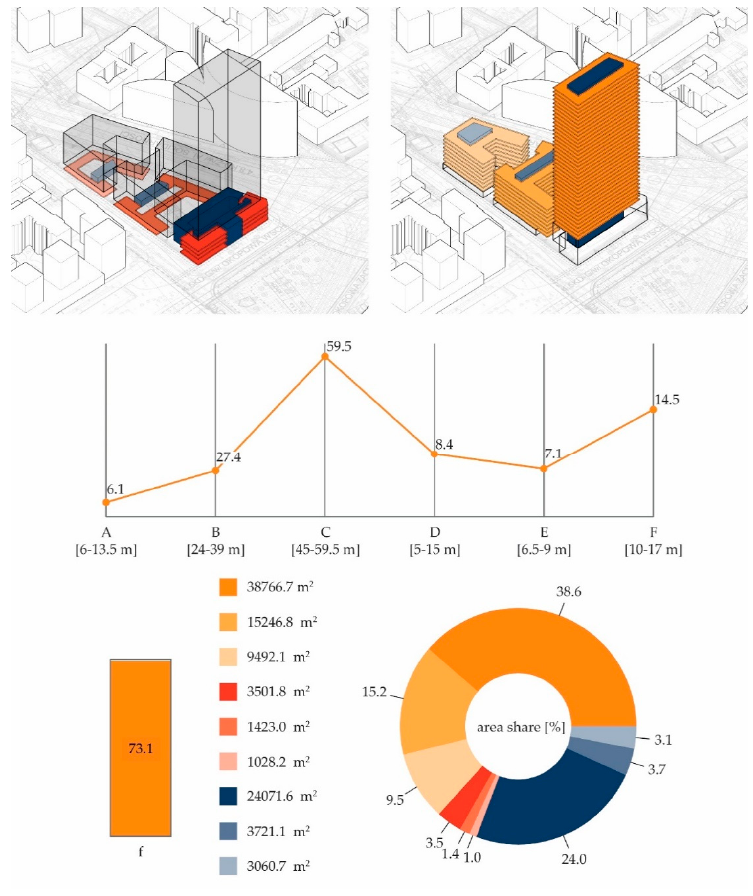
Figure 11. Solution chosen for further development.